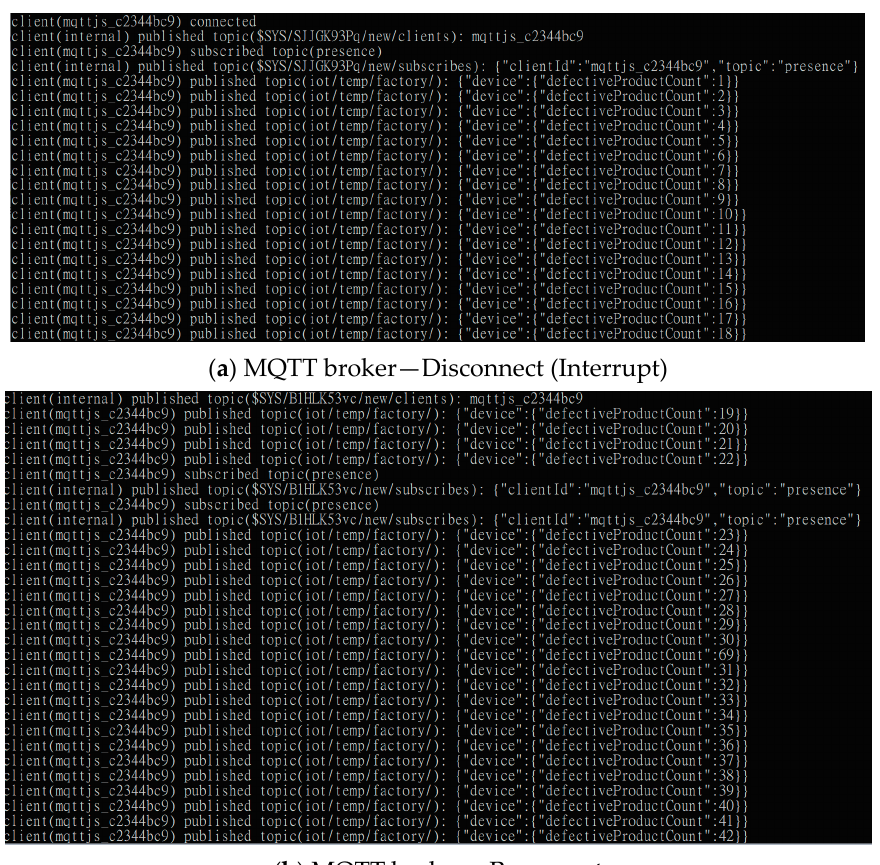
Figure 13. Data consistency validation results.